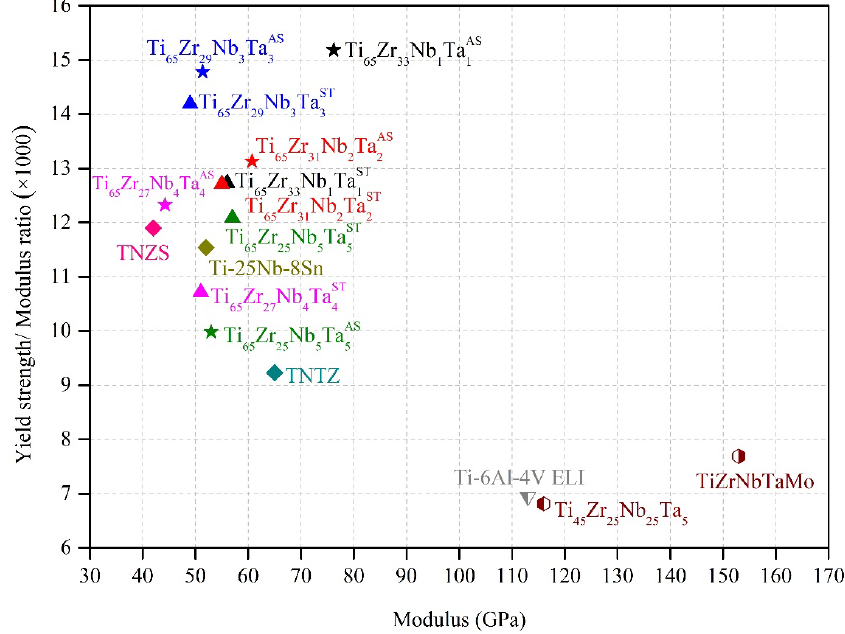
Figure 9. Yield strength–elastic modulus ratios ( × 1000) of the Ti–Zr–Nb–Ta MEAs under various conditions, several metastable β -Ti alloys [46–48], a bio-high-entropy alloy [3,45], and biomedical alloys [13].